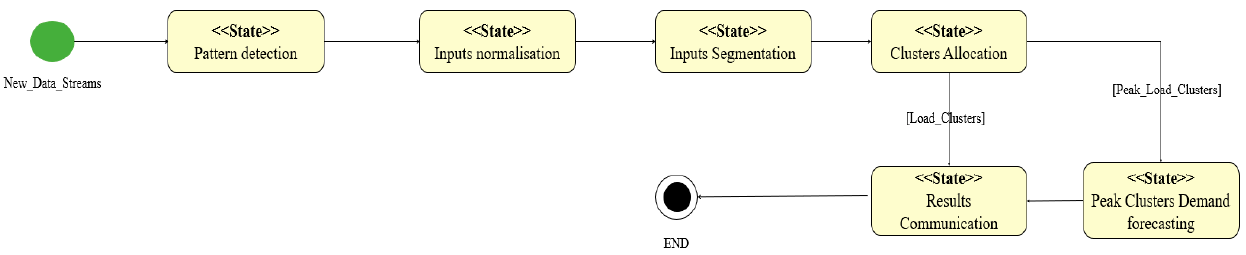
Figure 9. Plan model for load forecasting.